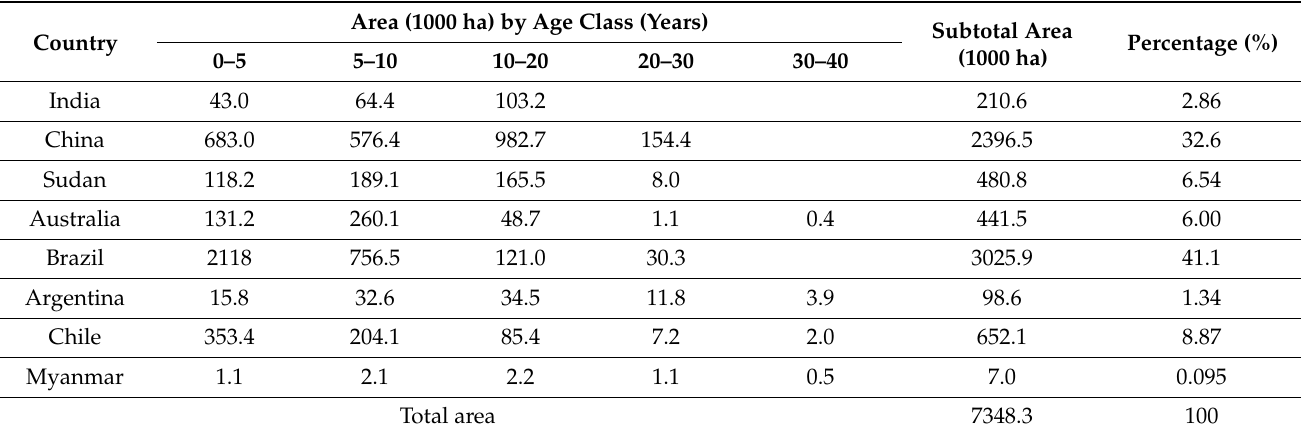
Table 6. Area of productive eucalyptus plantations by country, species, and age